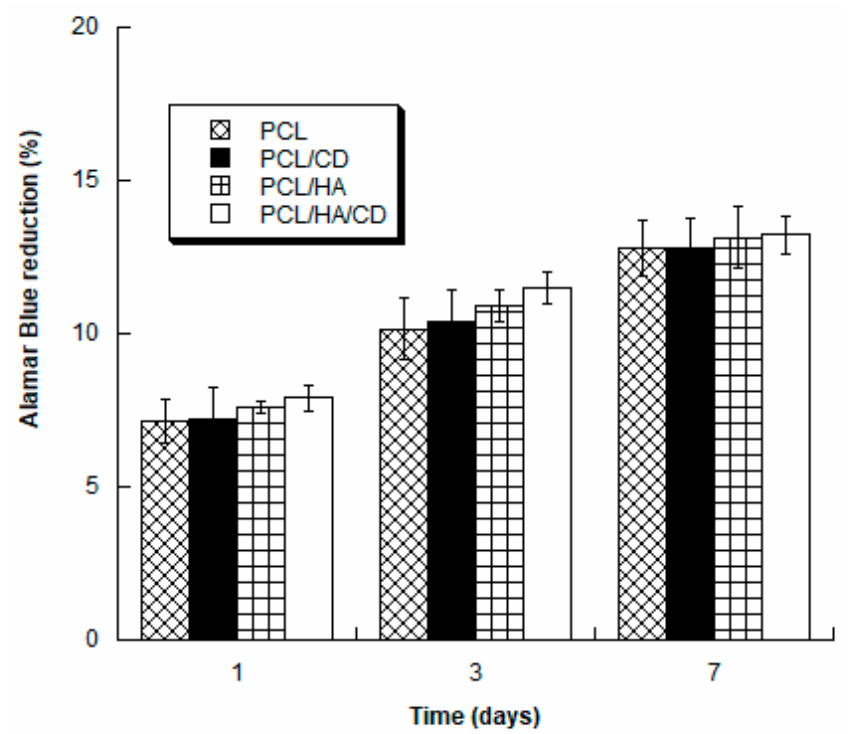
Figure 7. Alamar Blue reduction (%) evaluated for PCL, PCL/CD, PCL/HA and PCL/HA/CD at different time points.